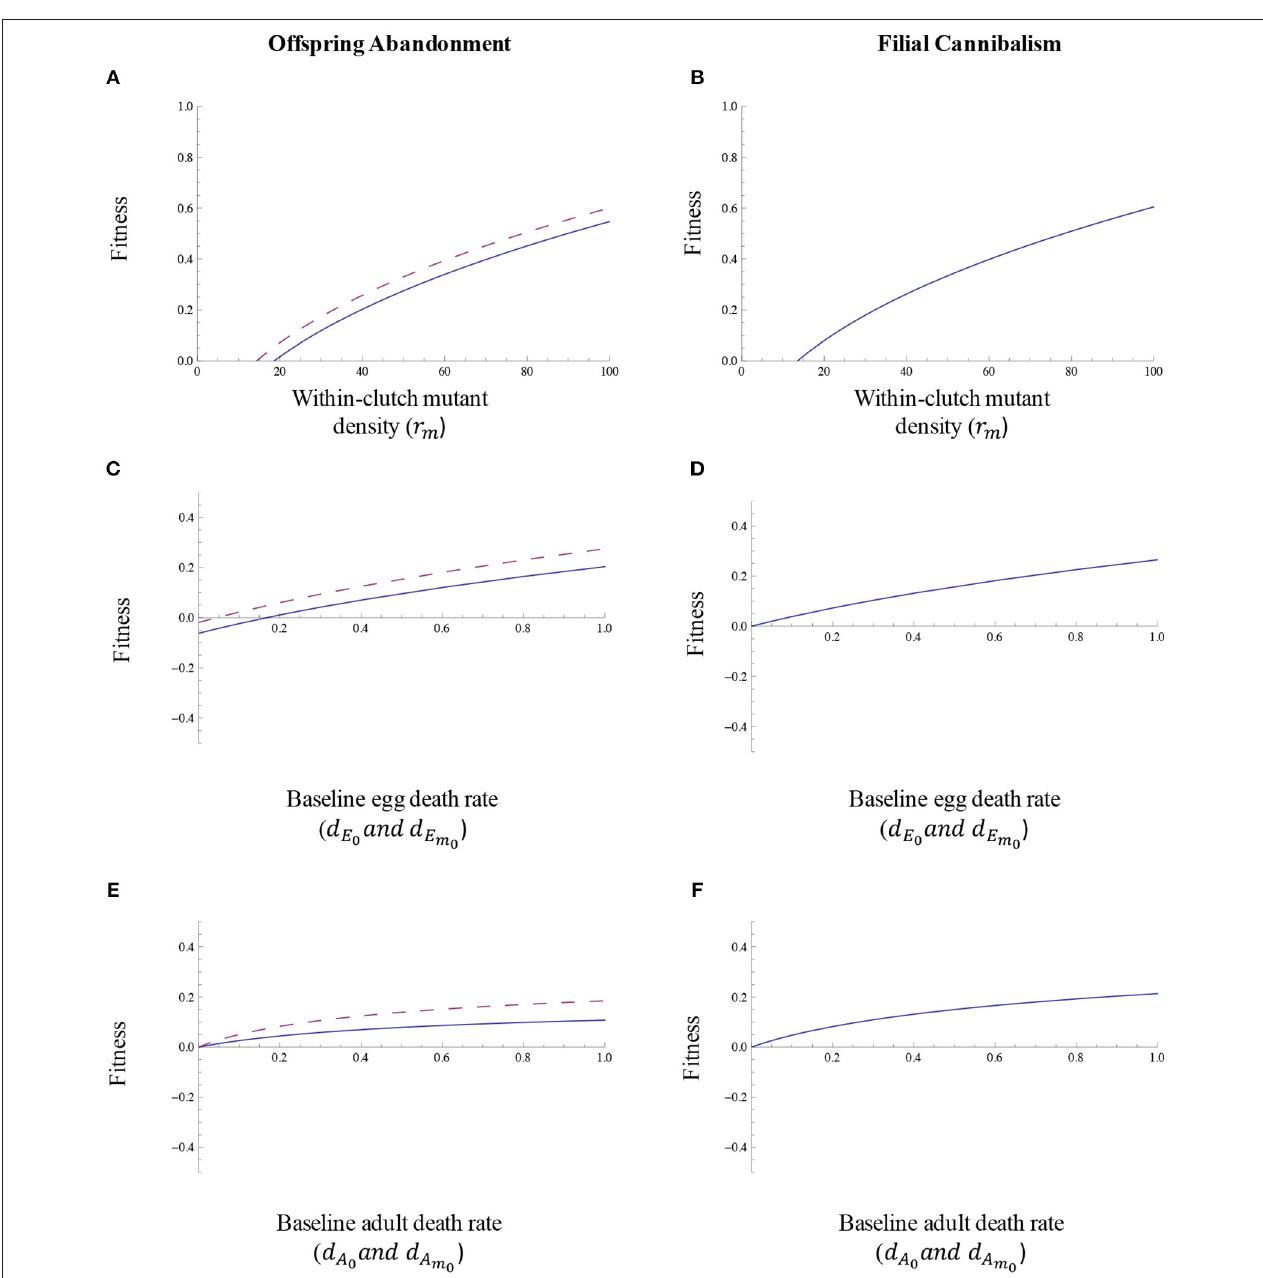
FIGURE 7 | The relationship between (A,B) within-clutch mutant egg density, (C,D) baseline egg death rate, (E,F) baseline adult death rate and the fitness associated with offspring abandonment and filial cannibalism. In these scenarios, we assume that density effects are present and that; all other parameter values are as described in the text. For offspring abandonment, the solid line illustrates the scenario in which abandonment initially decreases offspring survival (abandonment scenario 1) and the dashed line illustrates the scenario in which abandonment initially increases offspring survival (abandonment scenario 2).